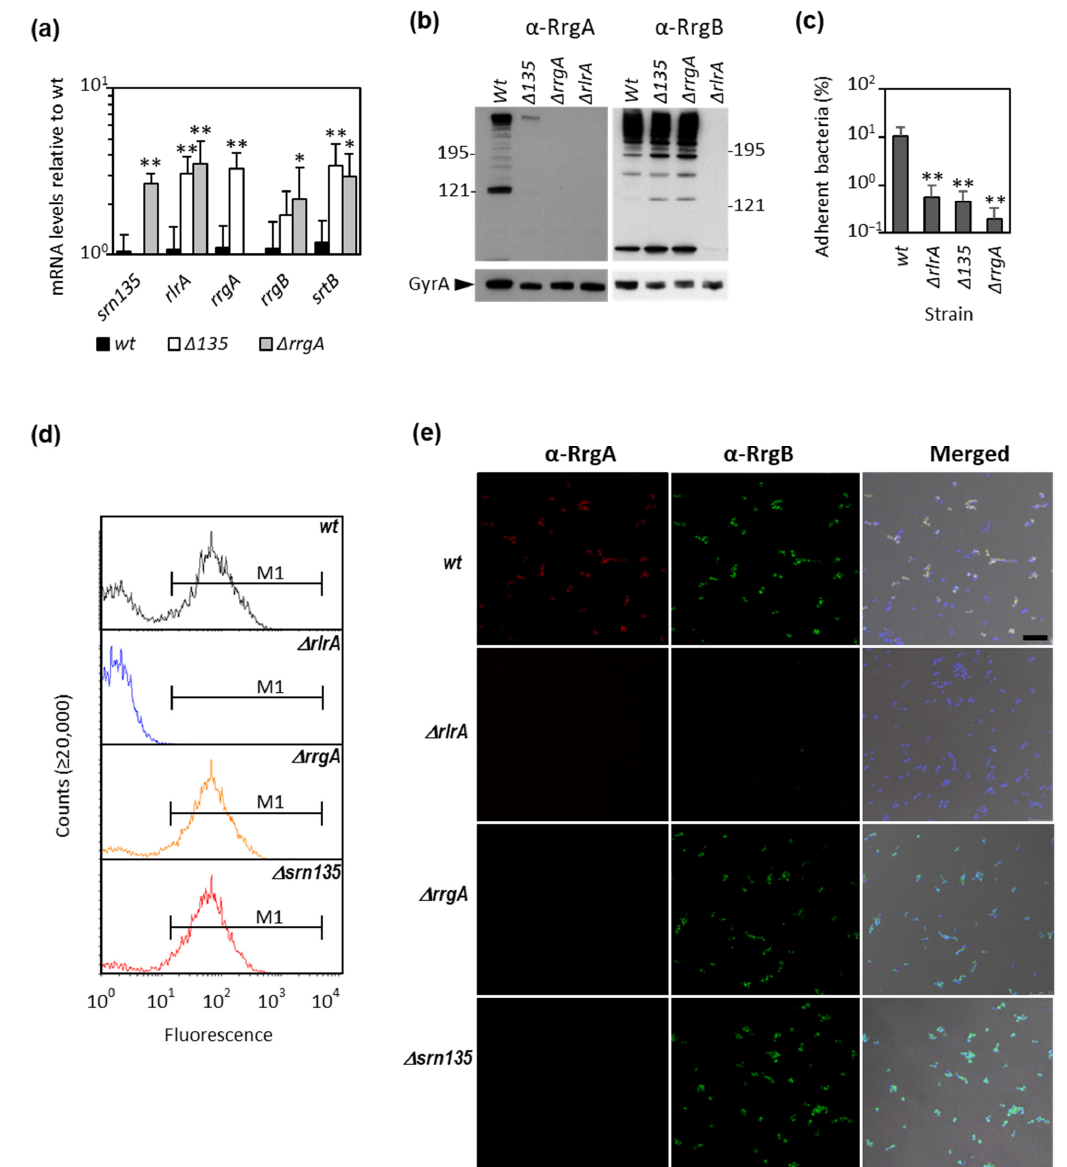
Figure 2. Deletion of the srn135 or rrgA gene results in an equivalent phenotype. Pilus expression in parental (wt), Δ 135 , and Δ rrgA mutant strains were studied. ( a ) Cultures were grown to mid-exponential phase, and RNA was extracted and used in quantitative RT-PCR analysis. Data represent transcript levels relative to the parental strain using the ΔΔ CT method. The results shown are the average of at least four independent experiments ( ± standard deviations). ( b ) Western blot of bacterial lysates using anti-RrgA ( α -RrgA) or anti-RrgB ( α -RrgB) as primary antibodies. A majority of the protein was found as a high molecular-weight ladder corresponding to the assembled pilus. Anti-GyrA antibody was used as a loading control. ( c ) Adherence to human epithelial lung cells was performed as described in Materials and Methods at an MOI of 50 bacteria per cell. Adherent bacteria were determined as the bound bacteria after 1 h incubation at 37 ◦ C relative to the number of inoculated bacteria. Results are the mean of five independent experiments ( ± standard deviations). ( d ) For flow cytometry, bacteria were labeled with rabbit anti-RrgB as primary antibody and Alexa Fluor 488 goat anti-rabbit IgG as a secondary antibody. Sera of mice immunized with PBS were used as a negative control. A representative histogram of wt, ∆ rrgA , ∆ rlrA , and ∆ 135 is shown. M1 denotes counted cells. ( e ) Bacteria were processed for immunofluorescence, stained with anti-RrgA ( α -RrgA), anti-RrgB ( α -RrgB) as primary antibodies, Alexa Fluor 488, and Alexa Fluor 647 as secondary antibodies, and DAPI for DNA staining. Imaging was performed with a Leica TCS-SP5-AOBS (Mannheim, Germany) confocal microscope. Merge signal of α -RrgA, α -RrgB, and DAPI staining is shown (Merged). The scale bar is 75 µ m. Statistical significance was tested by Student’s t -test with significant data points being highlighted by asterisks (* p < 0.05; ** p <